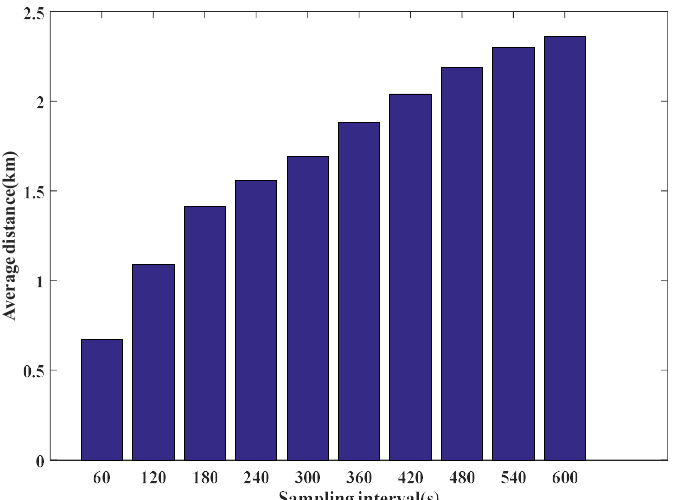
Figure 11. The average distance between two adjacent GPS points at different sampling rates.